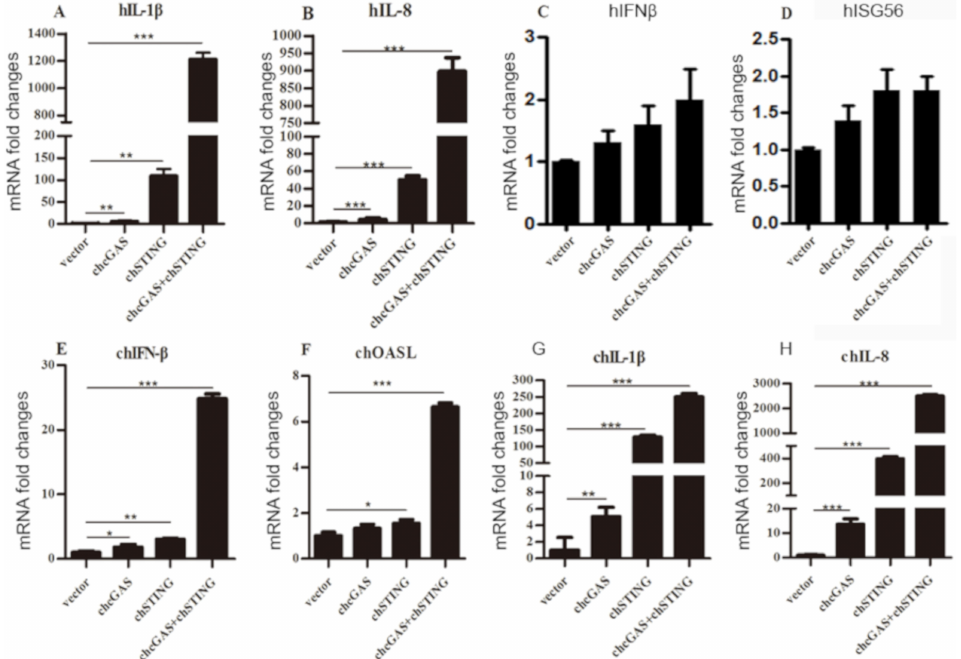
Figure 3. Cellular gene transcriptions activated by chcGAS and chSTING. ( A – D ) 293T cells grown in 12-well plates (4 × 10 5 cells / well) were transfected with chcGAS (0.8 µ g), chSTING (0.4 µ g) or combination using lipofectiamine 2000. Twenty-four hours post transfection, the cells were analyzed by RT-qPCR for downstream gene expressions as indicated. ( E – H ) HD11 cells in 12-well plates (4 × 10 5 cells / well) were transfected as in ( A – D ) using TransIT-LT1 Transfection Reagent, and 24 h later, cells were analyzed by RT-qPCR for downstream IFN β , OASL, IL-1 β and IL-8 gene expressions. The signs “*”, “**”, “***” denote p < 0.05, p < 0.01 and p < 0.001,